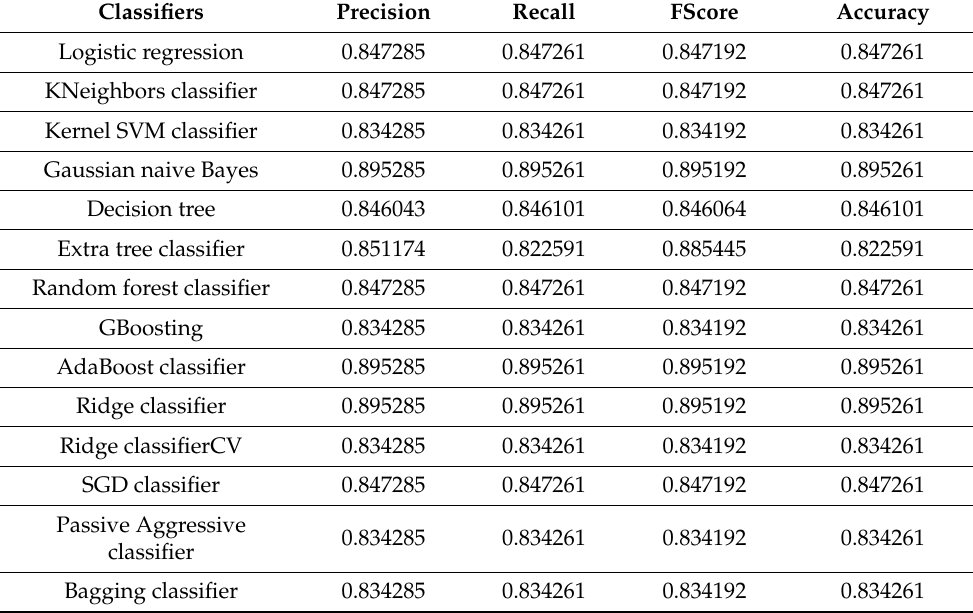
Table 12. Gradient boosting regressor metrics after feature scaling.